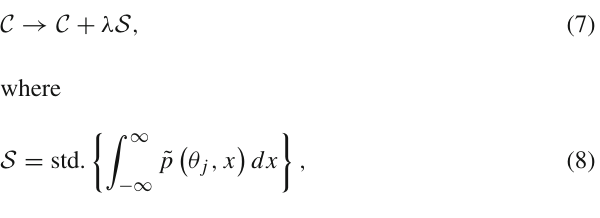
Fig. 4 Four of the ten template histograms used as training data for the single-input MDN of Sect. 5.2